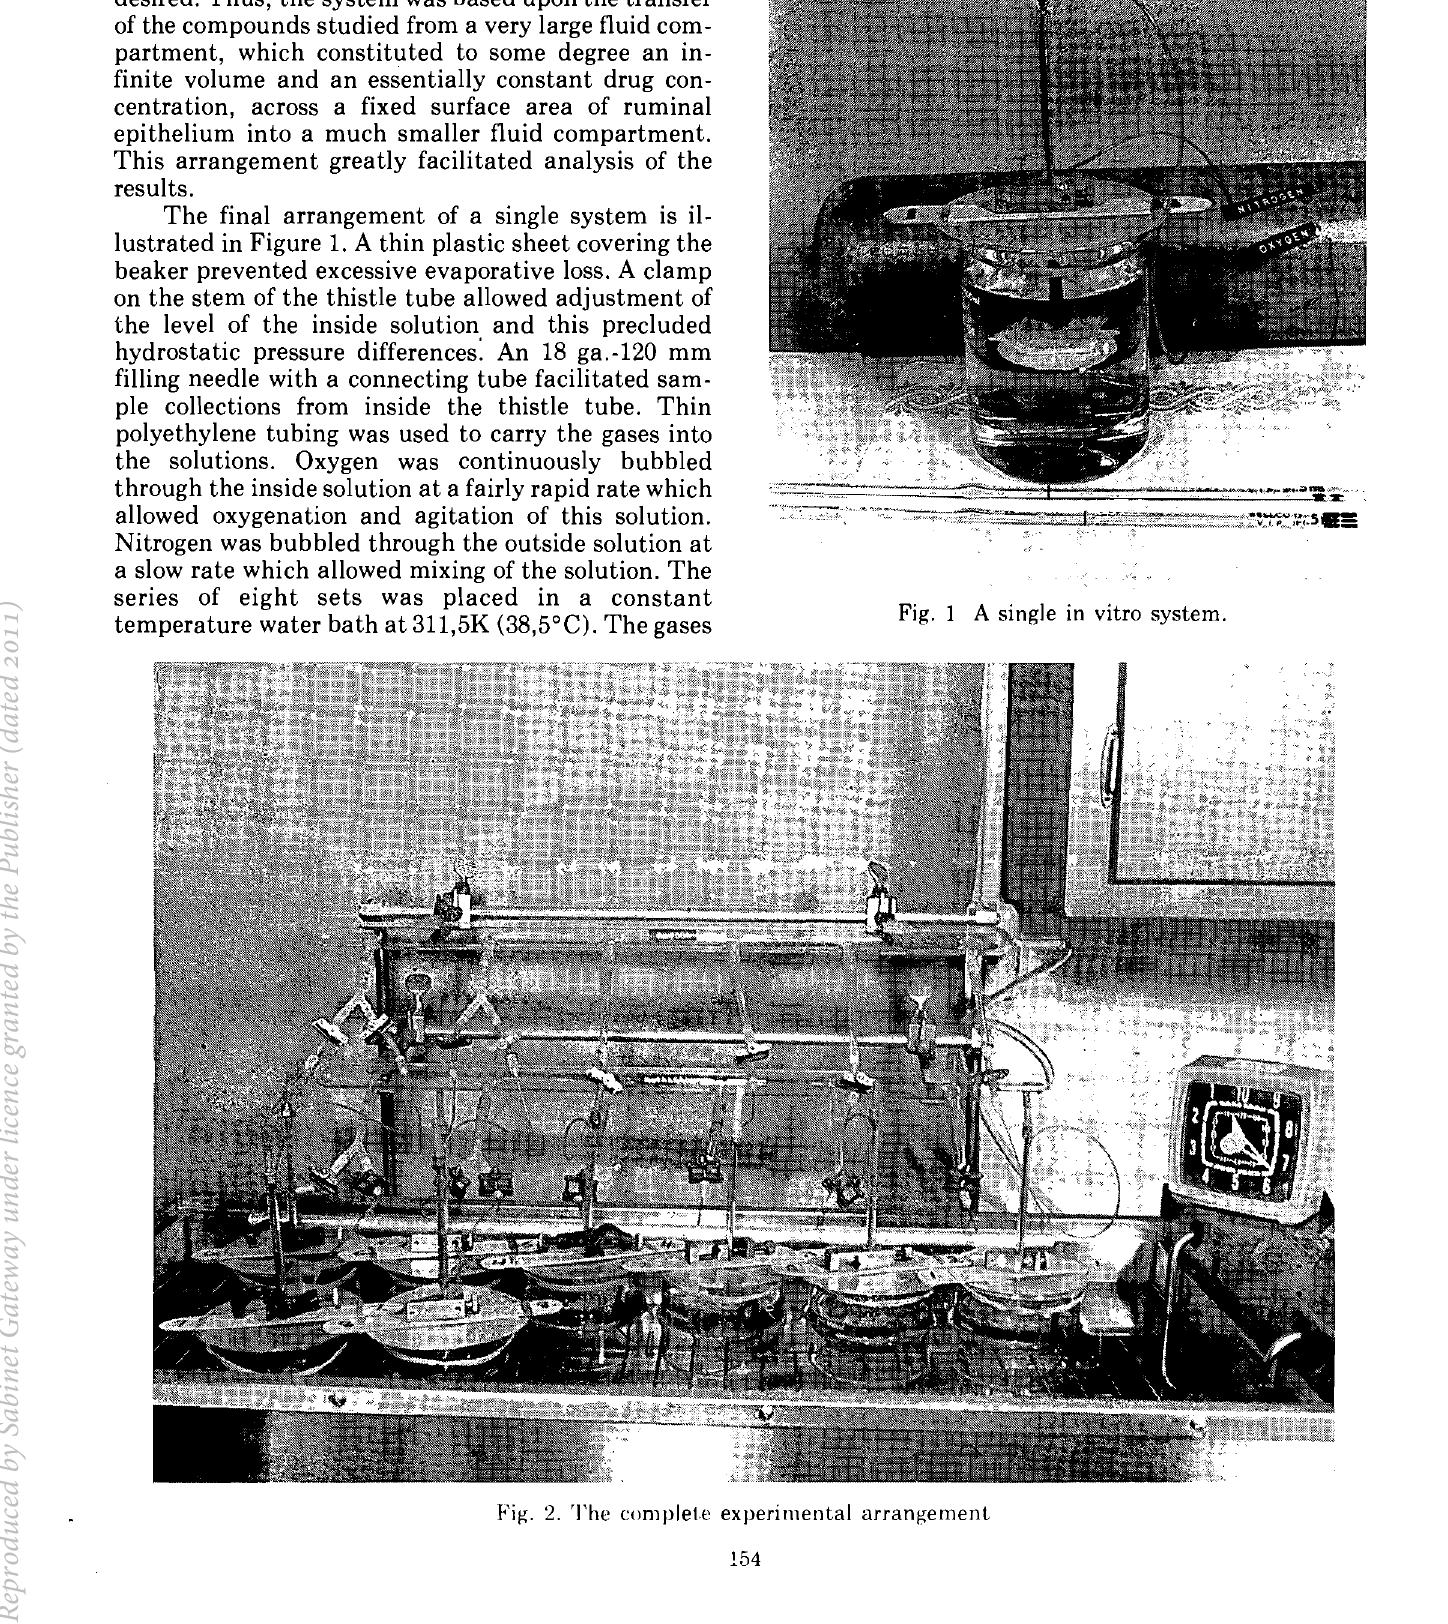
Fig. 1 A single in vitro system.